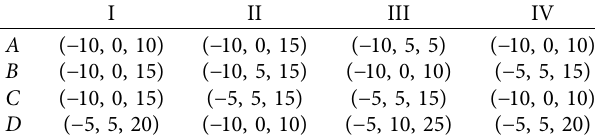
Table 7: Subtraction of the minimum interval in each column.